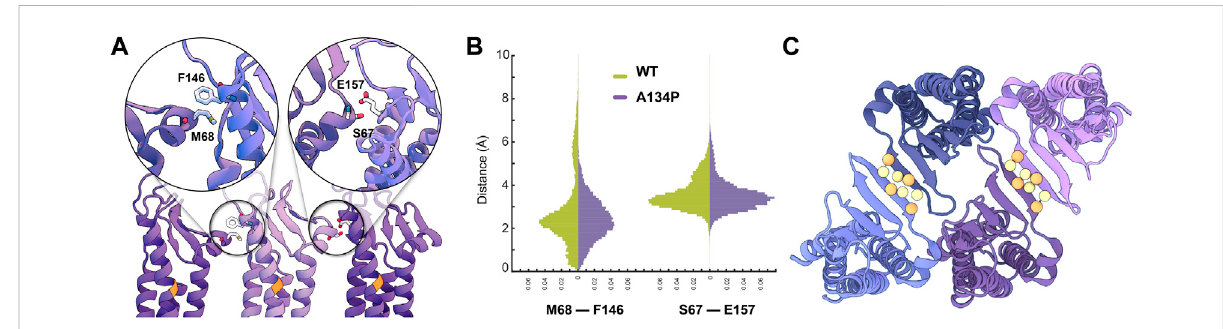
FIGURE 4 Side-by-side cis -interactions between WT and A134P claudin-15 strands. (A) A snapshot of three claudin-15 monomers in the single-layer strands after 500 ns of simulation in all-atom resolution highlighting two sets of side-by-side cis -interactions. (B) Pair-wise distance distribution of M68 (ECH) – F146 (TM3) and S67 (ECH) – F157 (ECS2) in the all-atom simulation of the single-layer WT and A134P mutant claudin-15 strands. The extendedtailofthedistributioninthecaseofWTsuggestsmore fl exibleside-by-sideinteractionsintheWTcomparedtotheA134Pmutant. (C) “ Face-to-face ” interactions between claudins are maintained through hydrogen bonds between the backbone of the β -sheets of claudins. These interactions are maintained throughout the simulation of both WT and mutant strands. The position of C α of residues involved in hydrogen-bonding is highlighted as